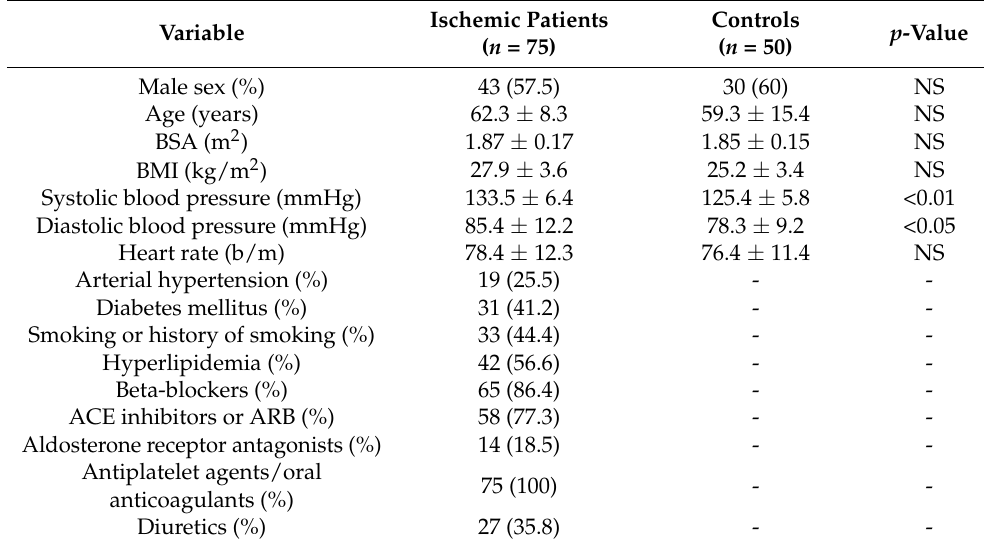
Table 1. Demographics and clinical features of the ischemic patients and healthy controls.